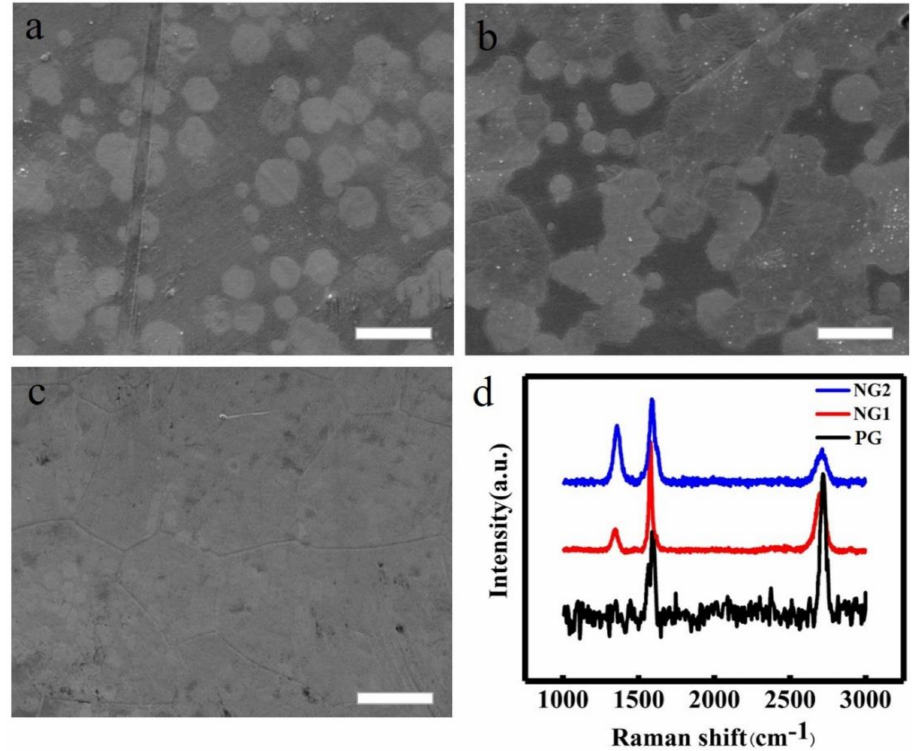
Figure 2. ( a – c ) SEM of fresh-prepared NG1-coated Cu in growth times of ( a ) 5, ( b ) 10, and ( c ) 20 min, respectively. Scale bar is 10 µ m. ( d ) Raman spectra of fresh-prepared PG-, NG1-, and NG2-coated